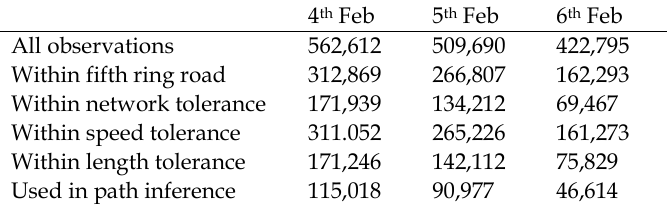
Table 1. The result of the filtering process